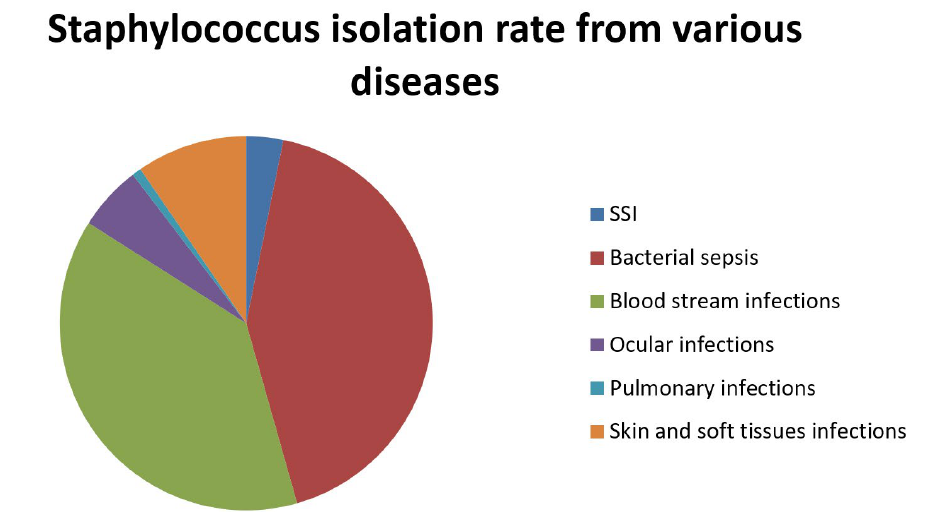
Fig. 2. Staphylococcus isolation from various